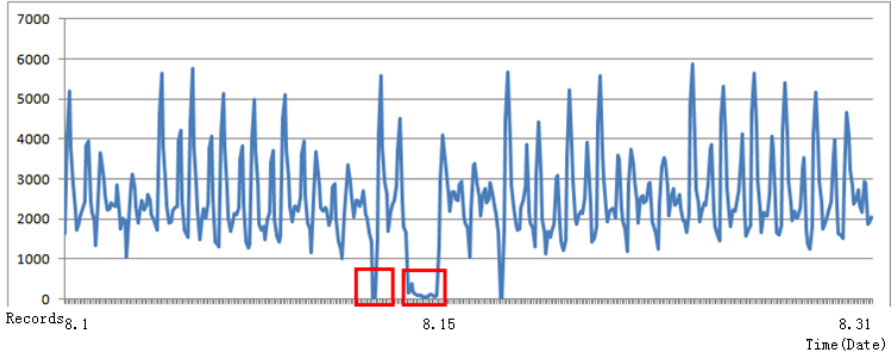
Figure 2. Dirty data examples from Bus Line